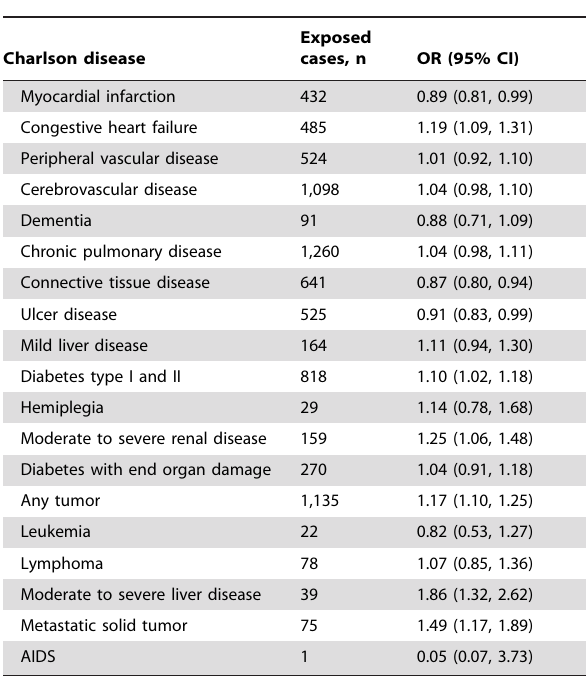
Table 3. Individual diseases included in the Charlson Comorbidity Index (CCI) three to ten years preceding the index date and their association with breast cancer incidence.